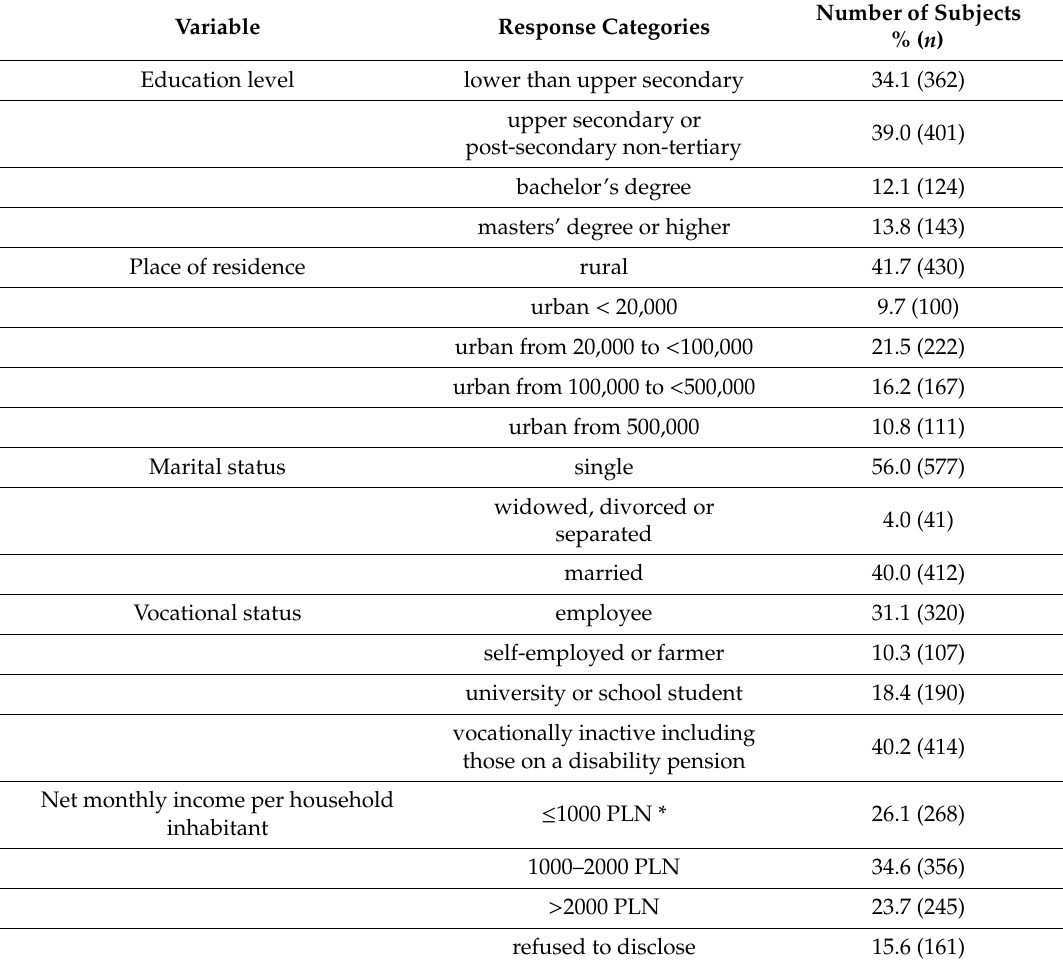
Table 1. The characteristics of the study